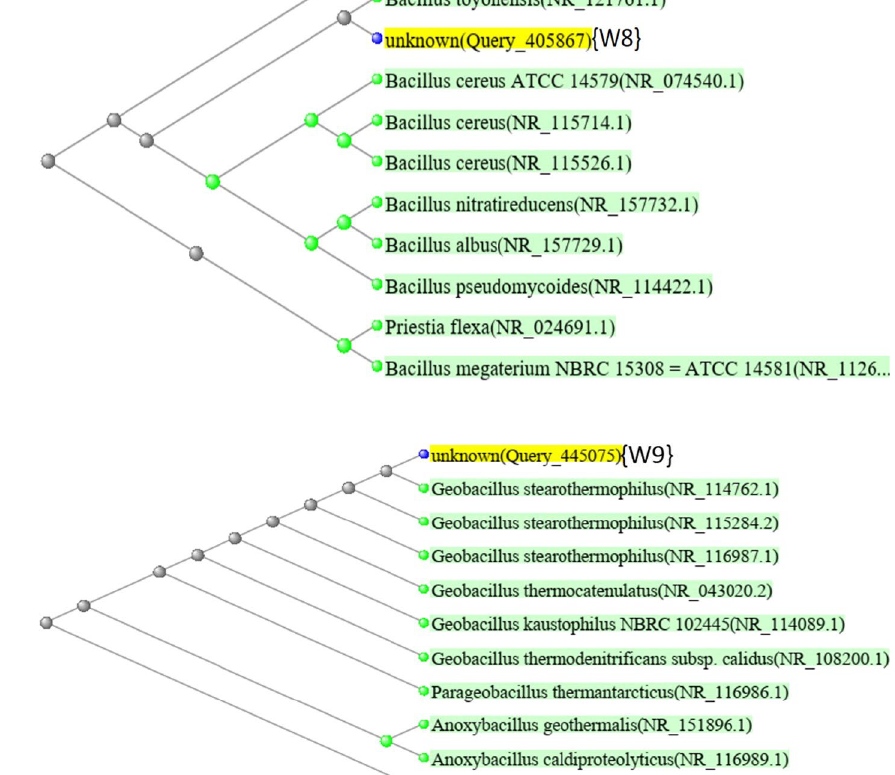
Fig. 2 Phylogenetic tree of the Bacillus toyonensis strain in contrast to the most closely related bacterial strain in the NCBI database ( Bacillus toyon- ensis NR_121761.1)